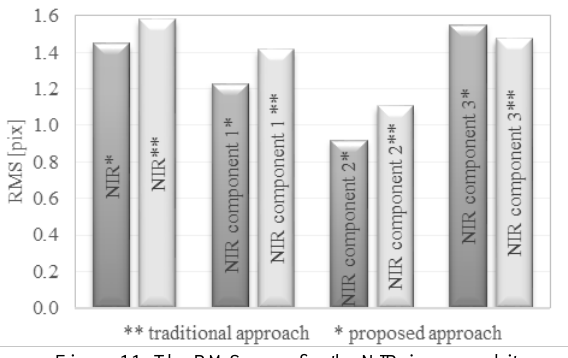
Figure 11. The RMS error for the NIR image and its components using a traditional approach and using the proposed approach